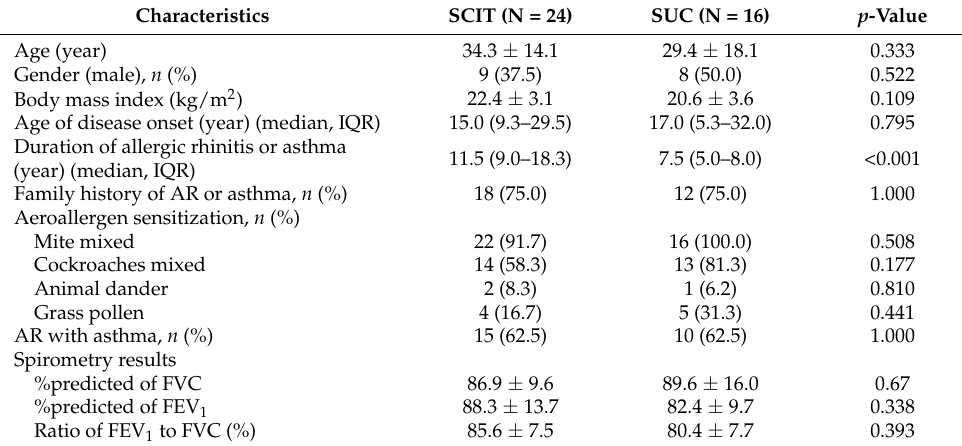
Table 2. Baseline characteristics of study participants.